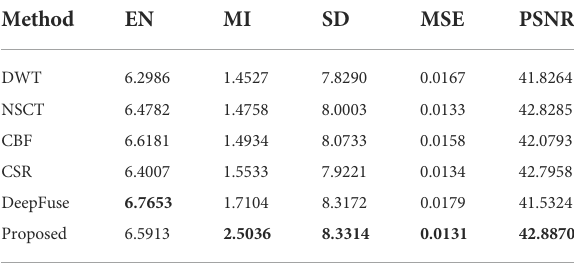
TABLE 2 Comparison results of evaluation metrics for image (a).